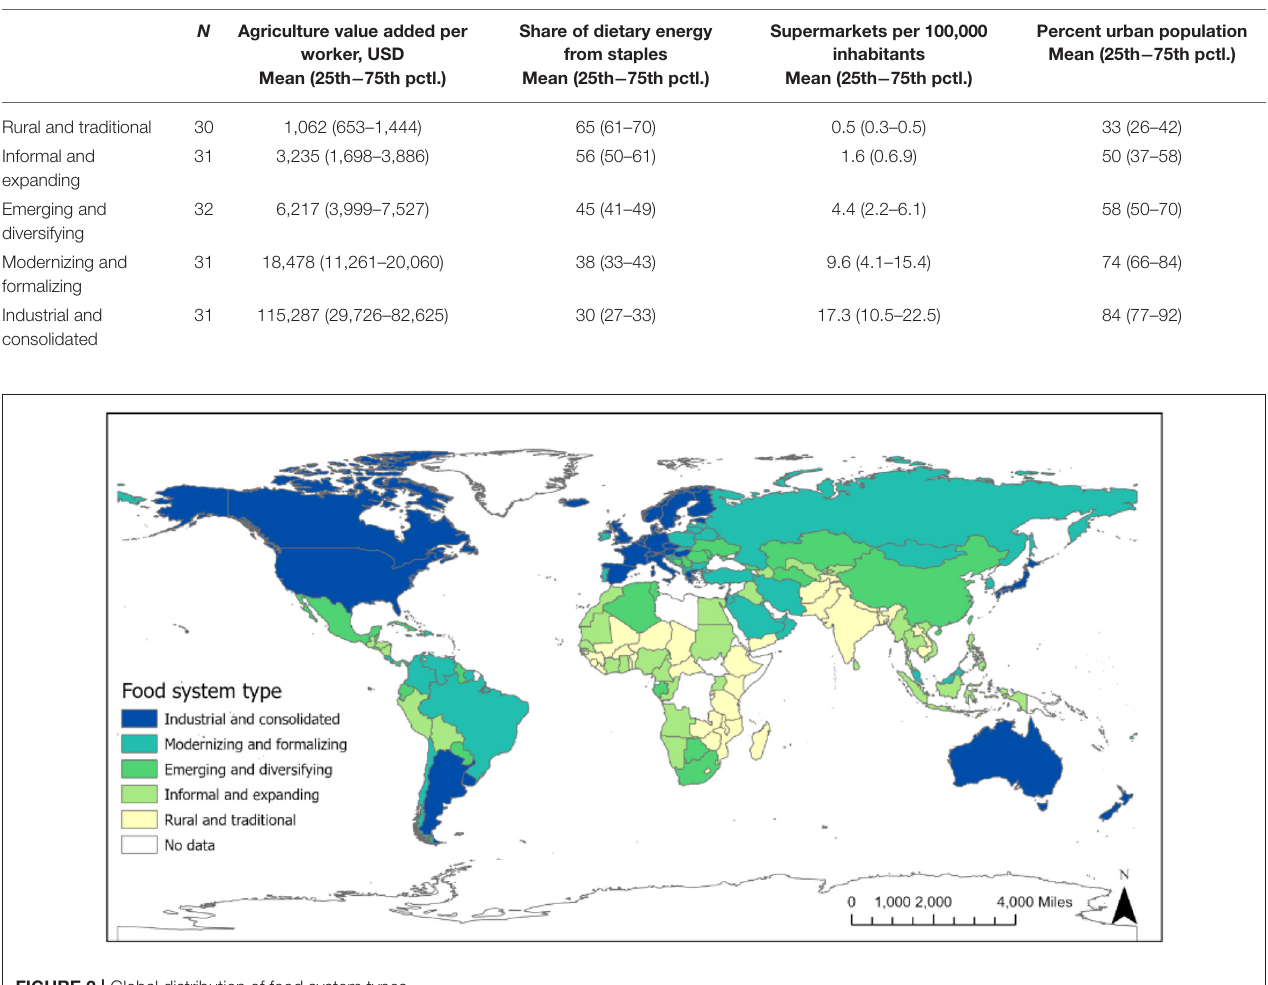
FIGURE 2 | Global distribution of food system